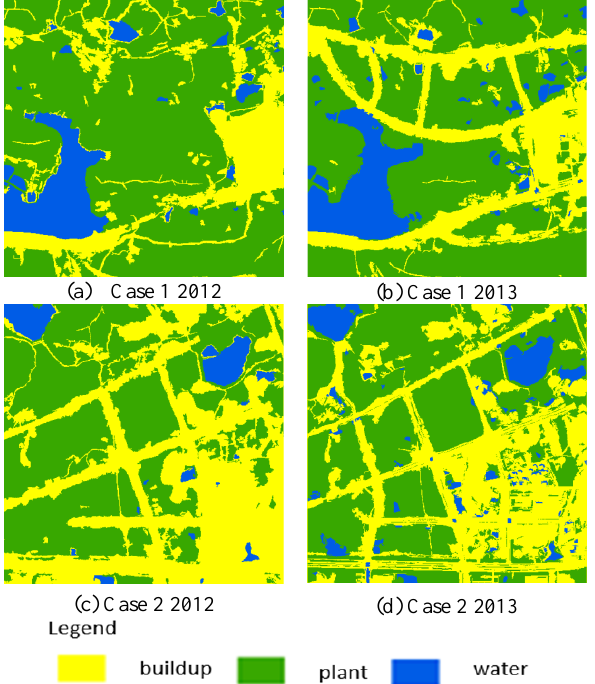
Figure 6 Classification Results of Multi-scale CART Tree The results of multi-scale CART tree classification is presented in Figure 6.